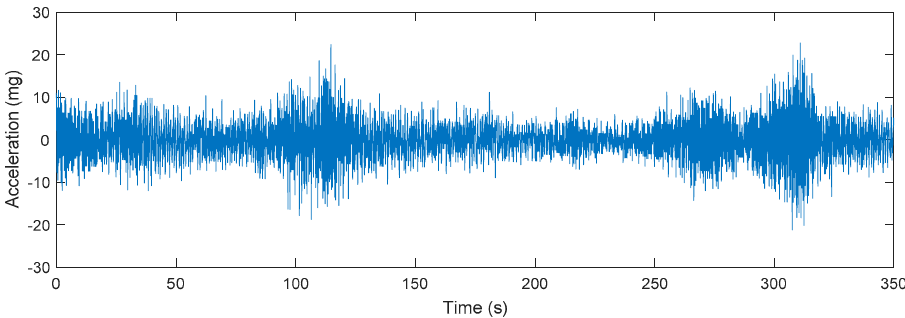
Figure 6. A sample measured acceleration time history from Jindo Deck on 05 June 2012.